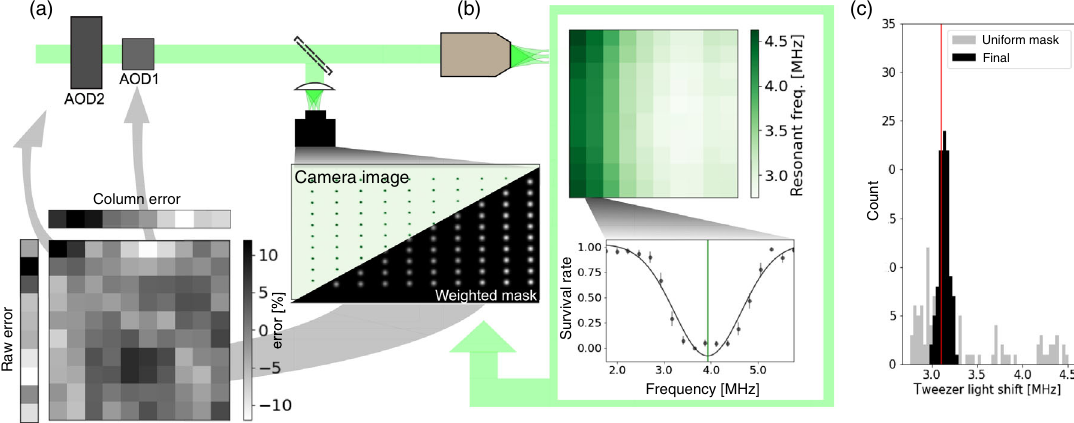
FIG. 8. Procedure employed to optimize tweezer balance. (a) Each tweezer ’ s intensity distribution is measured with light picked off before the objective lens and focused onto a camera. The intensity measurement is multiplied by an experimentally determined weighted mask and used to determine the errors for each tweezer. From this 2D array of errors, row and column errors are extracted and 1 ). This proportionally fed back to AOD1 and AOD2, respectively. (b) Example of the spectroscopy result for a uniform mask ( M ij ¼ information is further utilized to generate a weighted mask. The frequency variable is the red detuning from free-space resonance. 1 = 2 resonance for the 100 individual tweezers. The (c) Initial (gray) and final (black) distributions of the 1 S 0 ↔ 3 P 1 , F 0 ¼ 3 = 2 , m F 0 ¼ red line shows the median of the initial distribution, which is the chosen target value for the